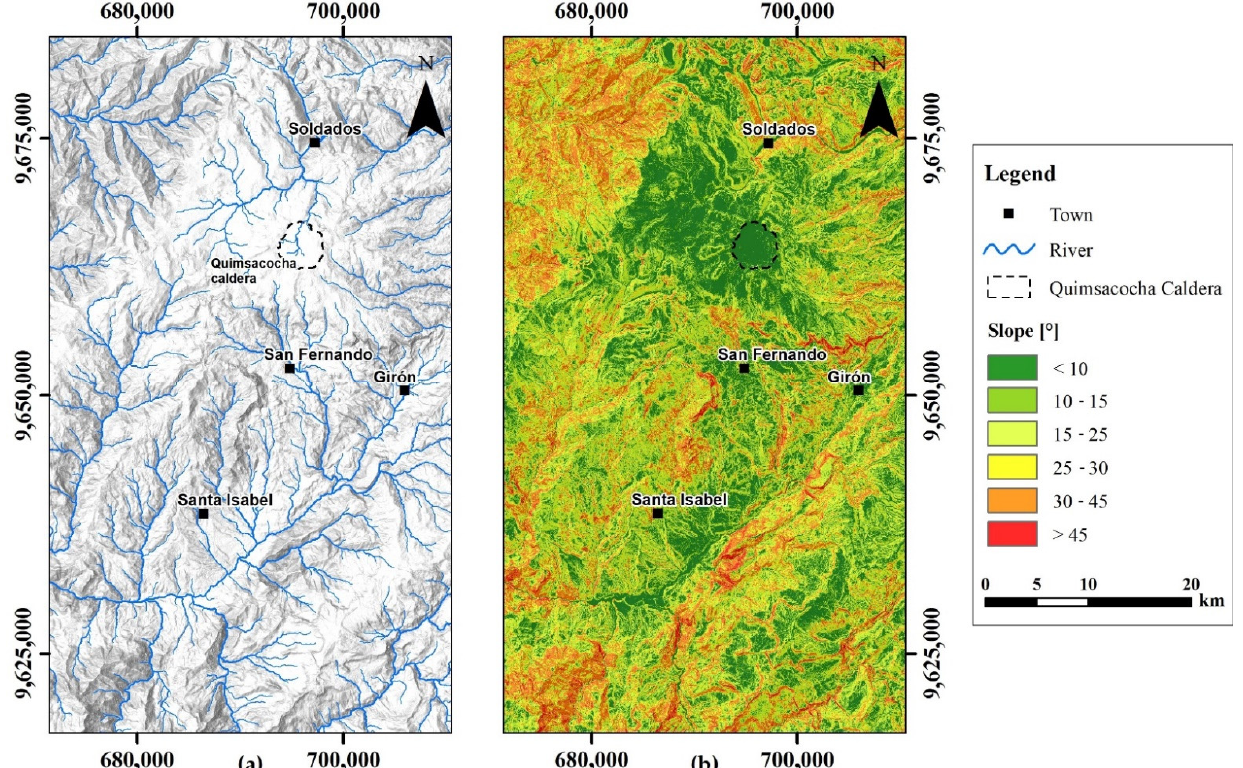
Figure 2 . ( a ) Drainage system and ( b ) slope model of the study